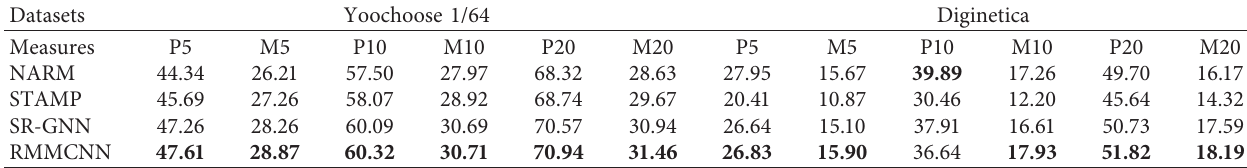
Table 5: The performance of various K (P5 means P@K with K � 5, M5 means MRR@K with K � 5, etc.).